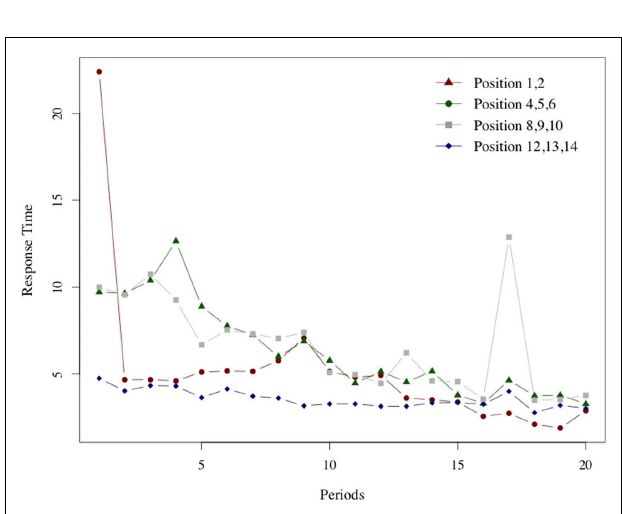
FIGURE 6 | Response times in losing positions, G (15, 3). For each of the 20 periods in which the game G (15, 3) was played we report the average response time at each of the losing positions, 3, 7, and 11.